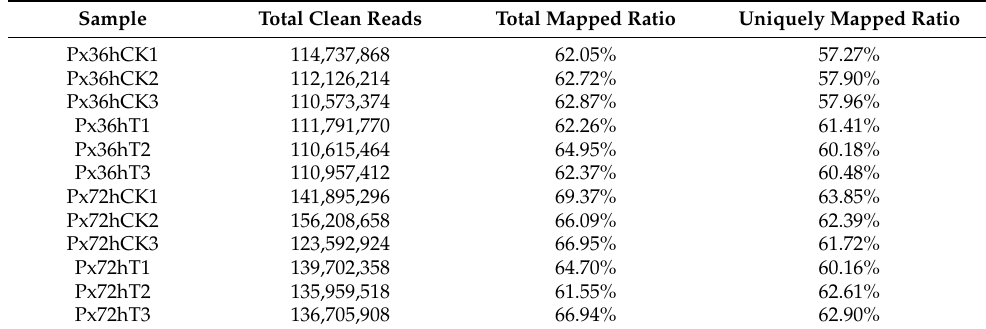
Table 1. Statistics of read align to reference